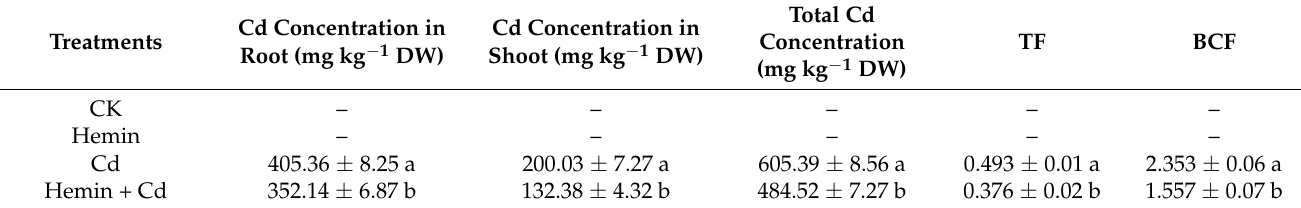
Table 4. Effects of hemin on Cd concentrations of shoot and root, total Cd concentration, the translocation factor (TF), and the bioconcentration factor (BCF) under Cd stress.